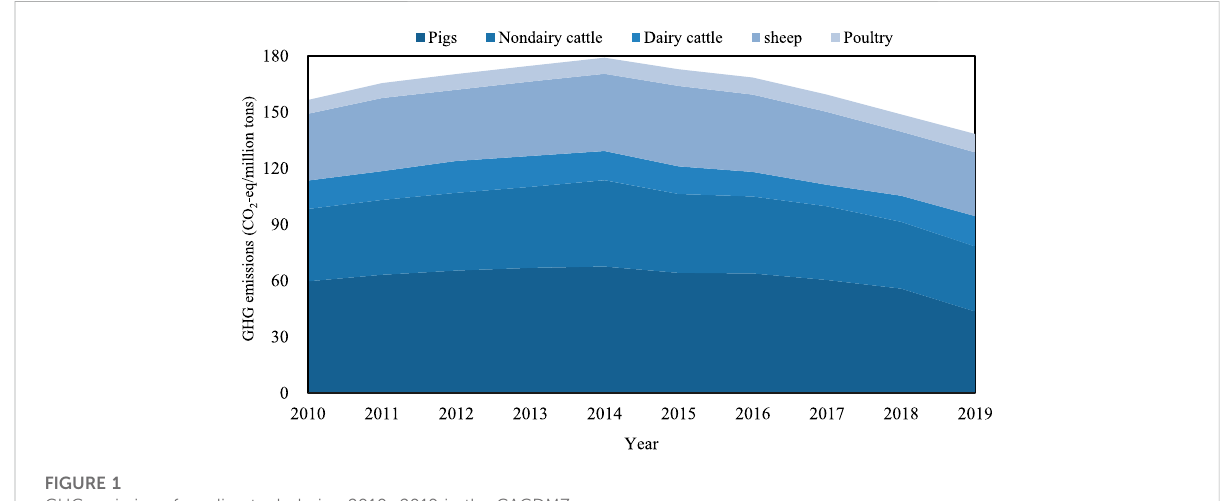
FIGURE 1 GHG emissions from livestock during 2010 – 2019 in the CAGDMZ.